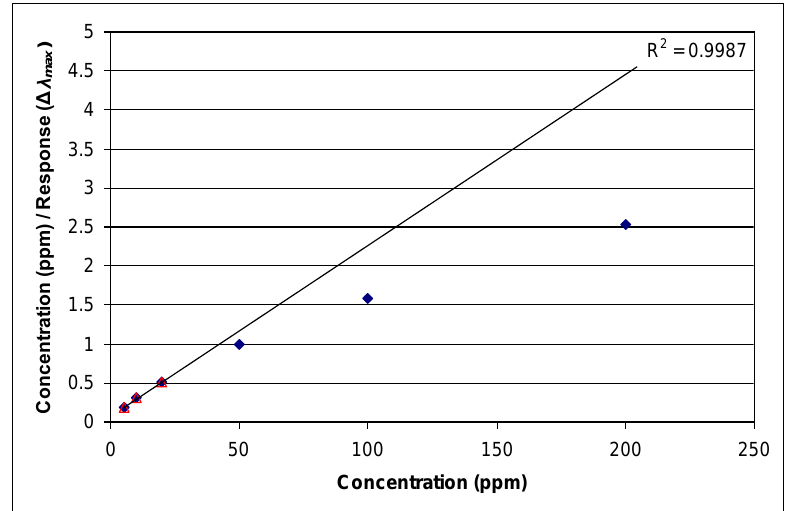
Figure 2. Example of linearization of data for m-xylene, demonstrating the absence of simple Langmuir behavior.